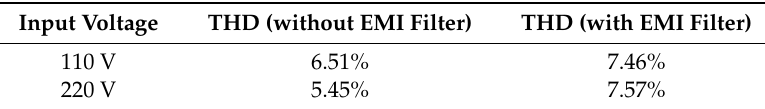
Table 2. THD analysis results.